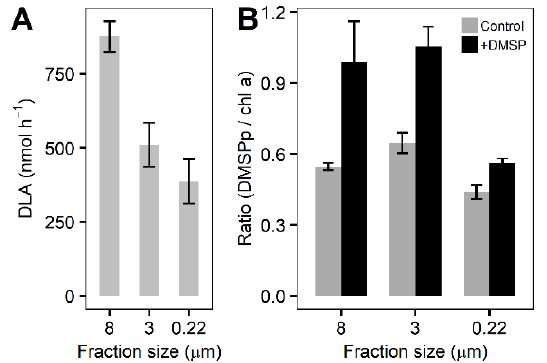
Figure 5. DLA and DMSPp at the final time point. ( A ) DLA for each fraction of the community at the final time point. ( B ) DMSPp concentrations normalized to chlorophyll a for control samples (light grey bars) and +DMSP samples (dark grey bars) for each fraction of the community at the final time. Data represent the mean ± standard deviation ( n = 4). ANOVA, 8 µm: F = 14.748, p = 0.012; 3 µm: F = 14.777, p = 0.012; 0.22 µm: F = 12.818, p = 0.023.